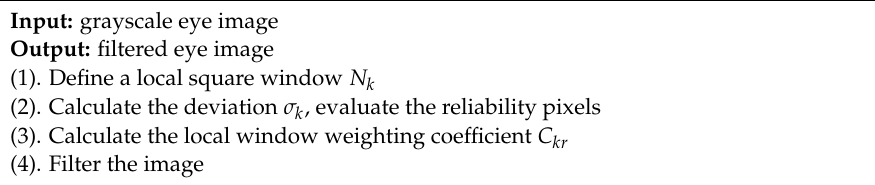
Algorithm 1: The adaptive feature extraction of local distribution intensity